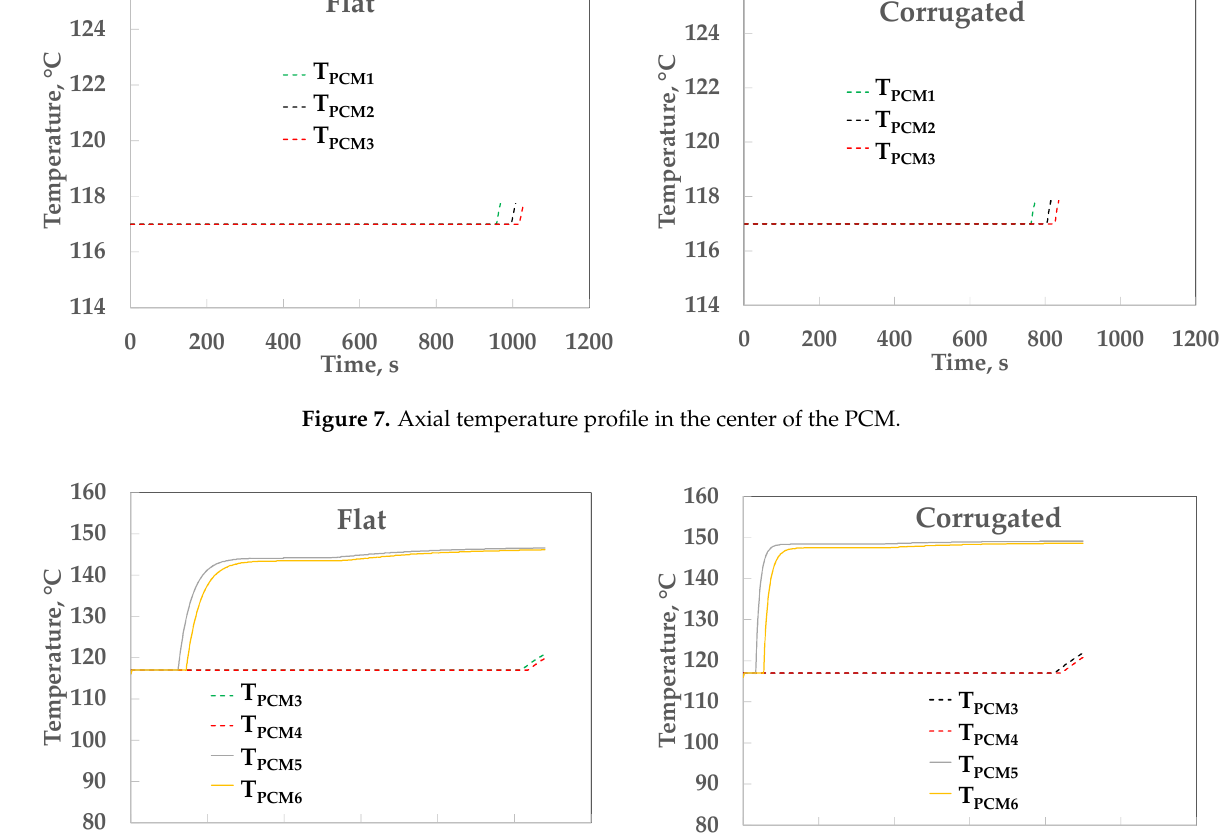
Figure 7. Axial temperature profile in the center of the PCM.